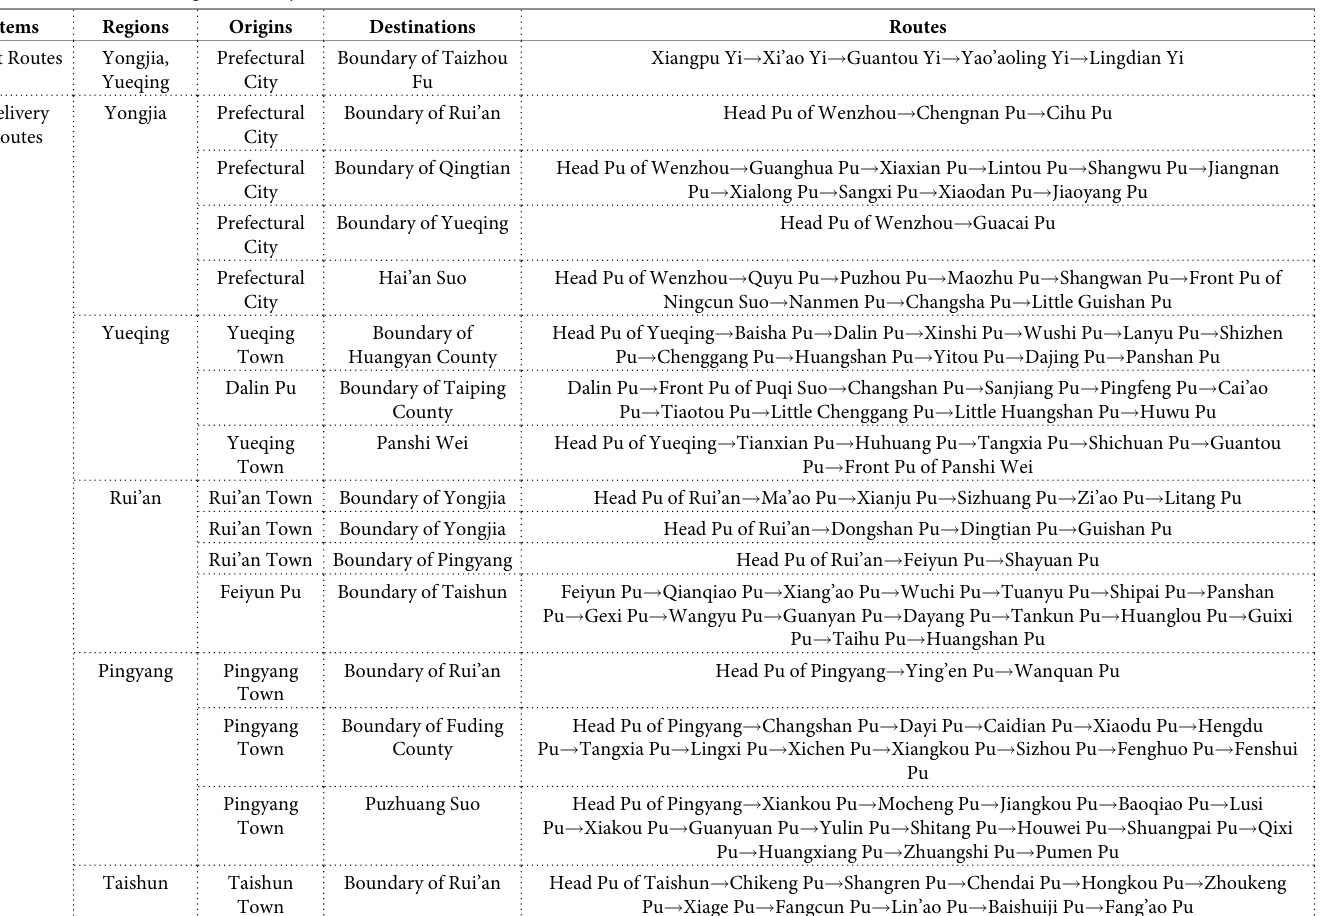
Table 3. Post routes and urgent delivery routes statistics.